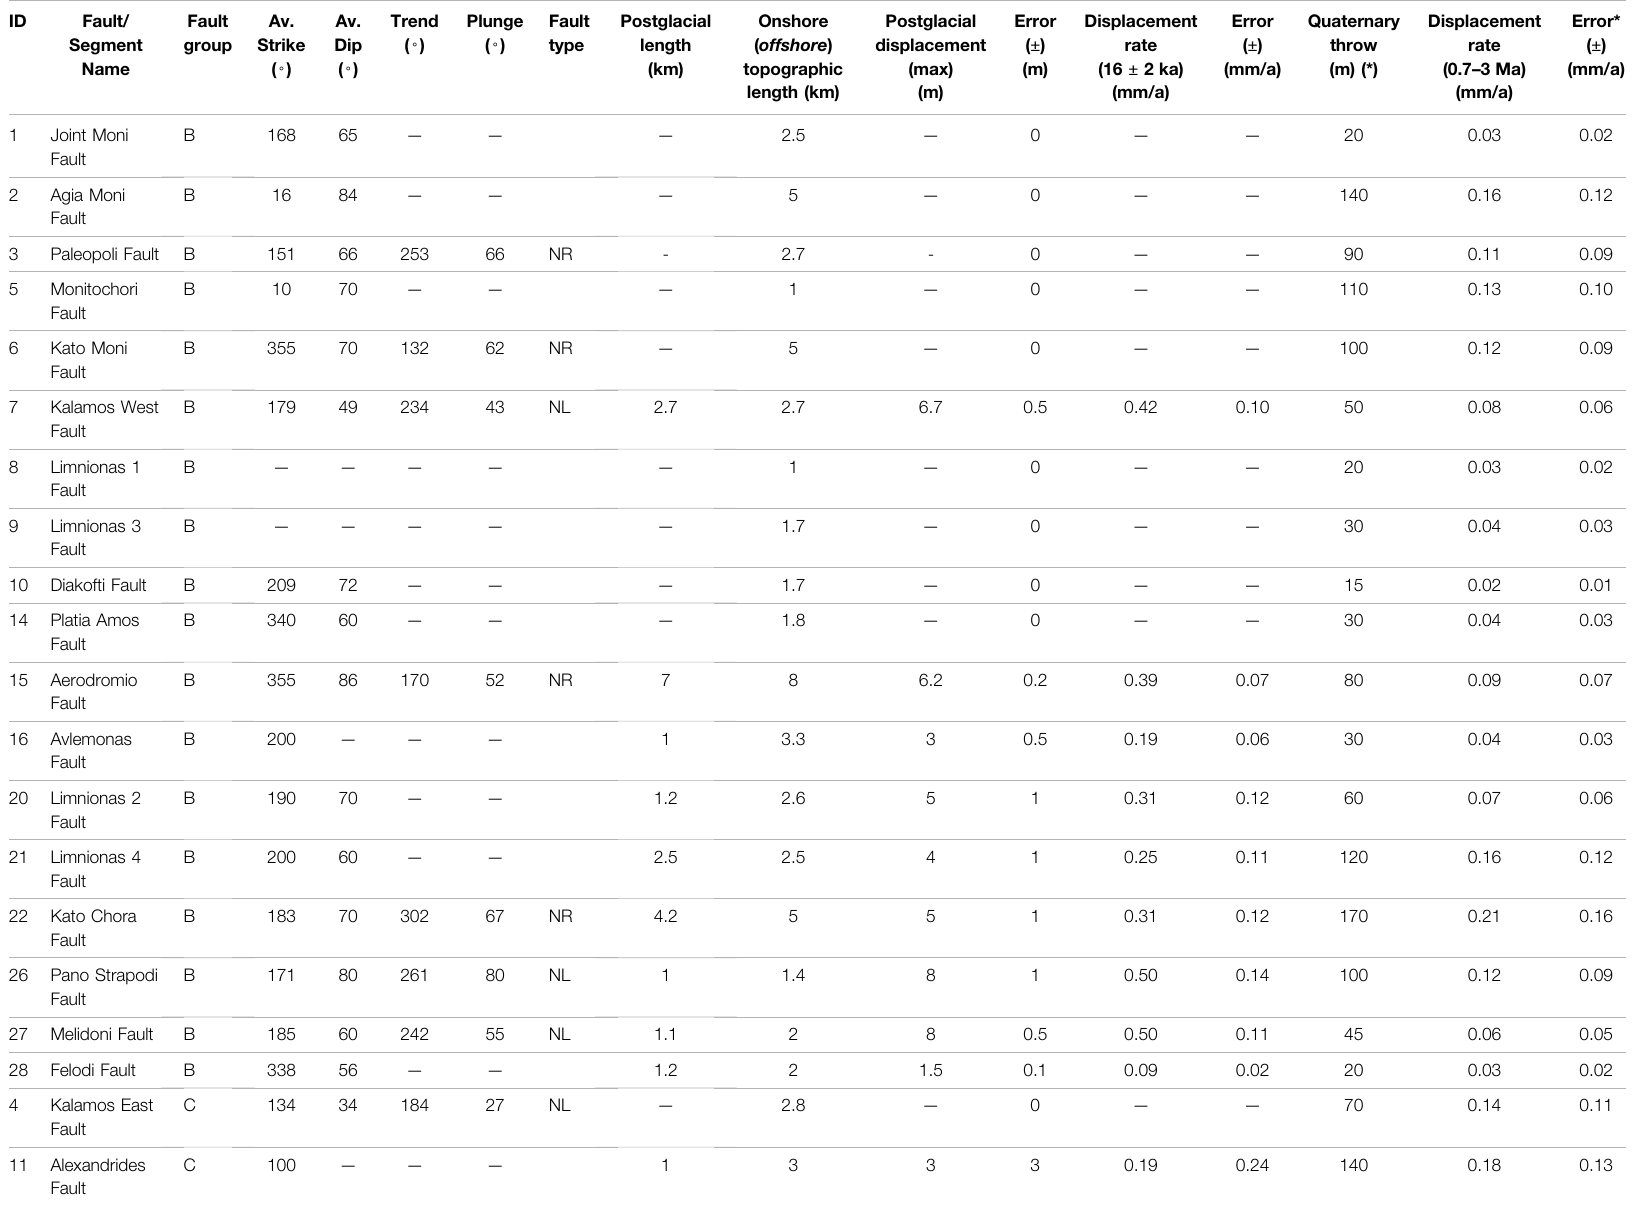
TABLE 1 | Table illustrating the main structural and kinematic characteristics of each fault on the island of Kythira (*error is calculated as +40% and − 20% of the total throw measurement; see text for